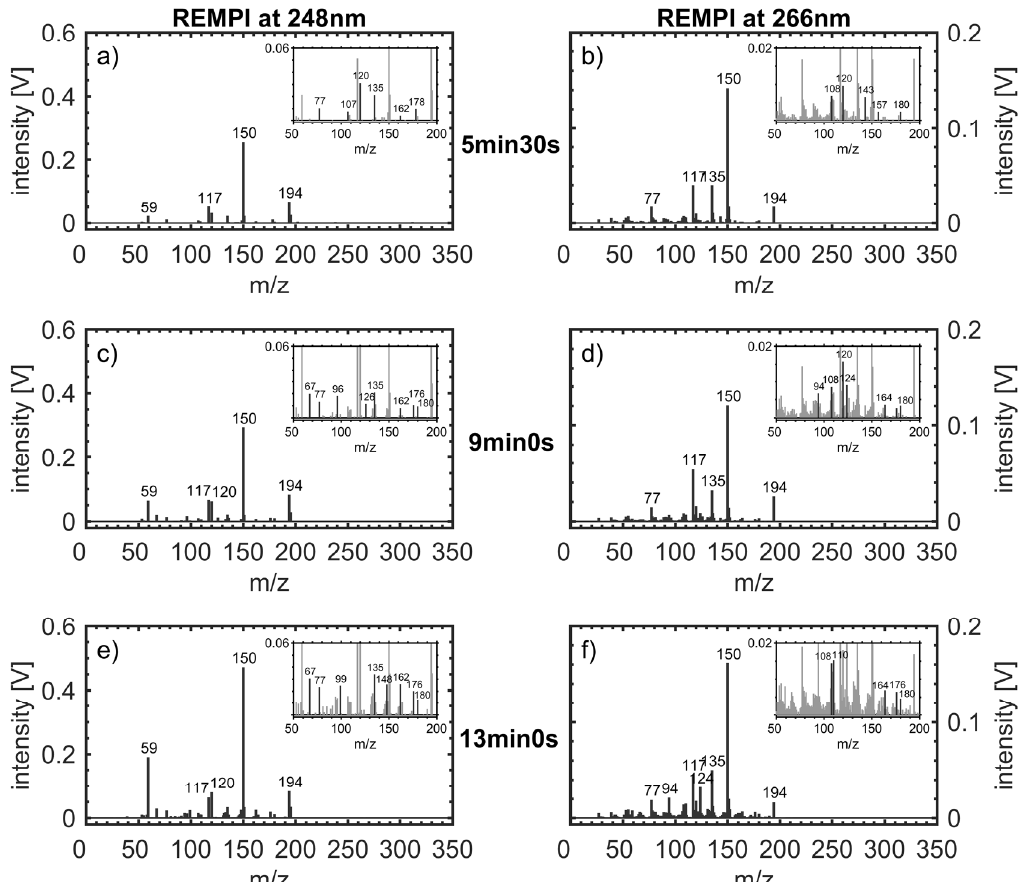
Figure A1. REMPI mass spectra at 248 nm (left) and 266 nm (right) for roasting times 5 min 30 s ( a , b ), 9 min ( c , d ) and 13 min ( e , f ). Table A1. List of most abundant ions and structures assigned from Hertz-Schünemann et al. (2013), Czech et al. (2016) and references therein.